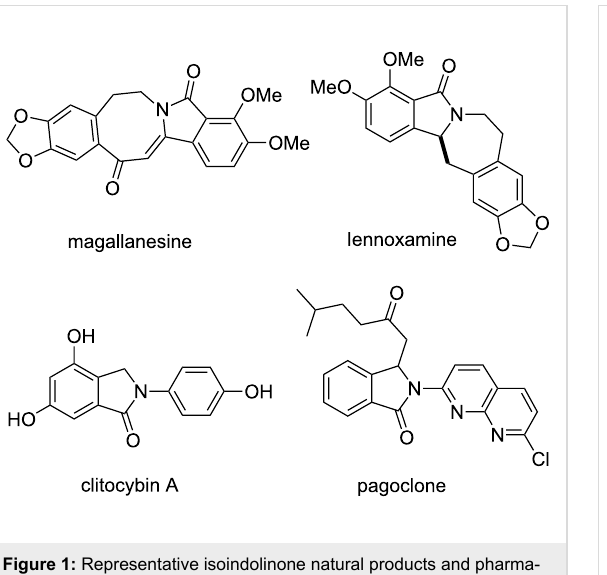
Figure 1: Representative isoindolinone natural products and pharma- ceuticals.